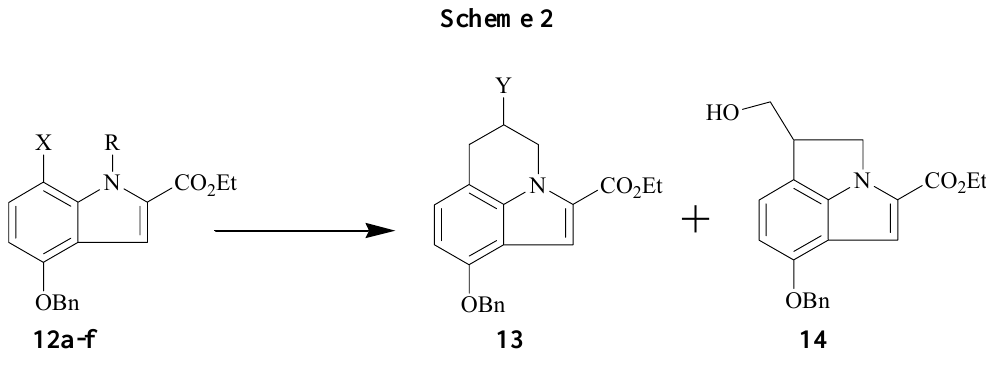
Table 1 : Synthesis of Pyrroloquinoline ( seco- PQC, 7 ) via Free Radical